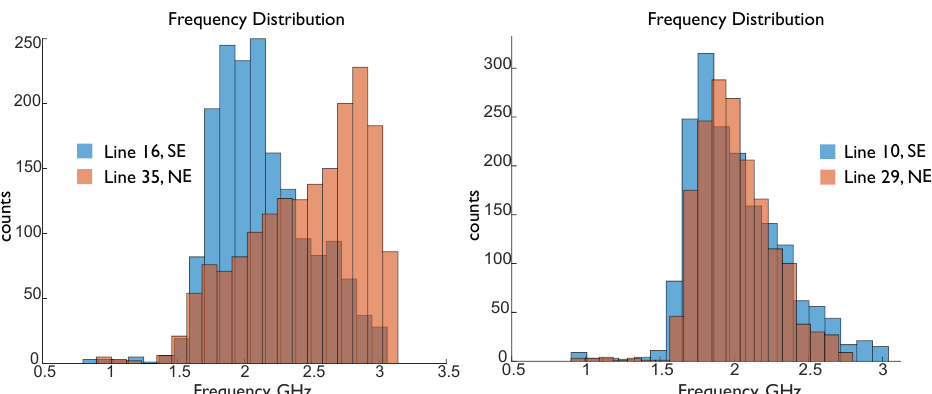
Figure 8. Frequency distribution of representative transect pairs 16 and 35 ( left ), and 10 and 29 ( right ), with a lower overall centroid frequency in the SE leg.